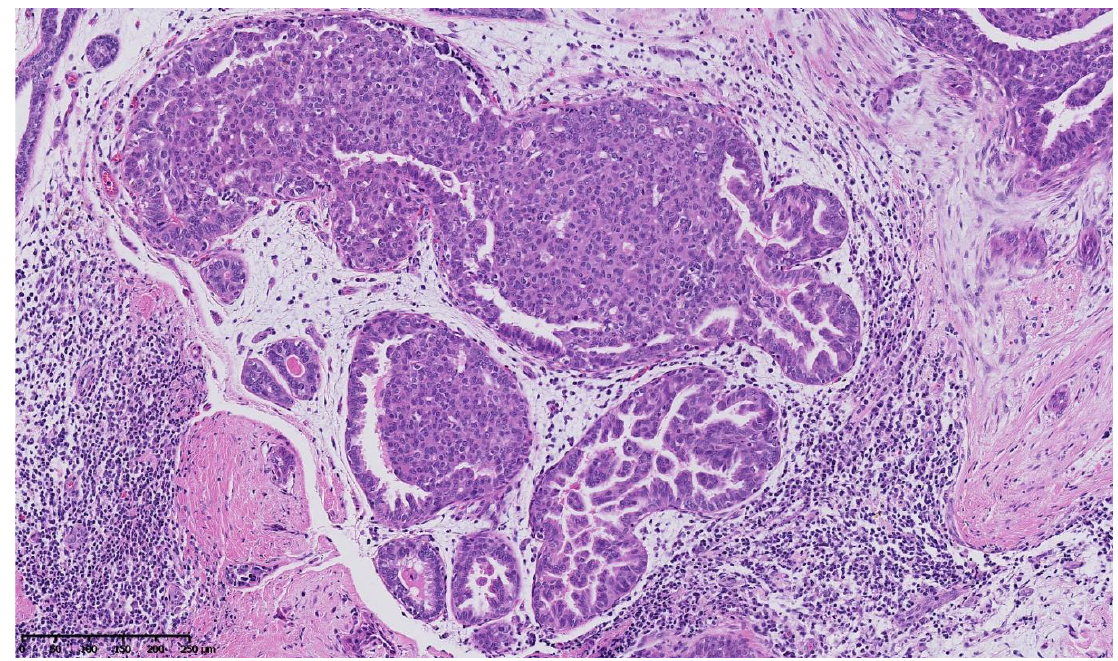
Figure 4. Hematoxylin and eosin staining: at mid magnification, the ducts vary in size, and some look irregularly shaped and pseudo-invasive in the retracted fibrous stroma, whereas others are enlarged and contain an intra-ductal epithelial proliferation.